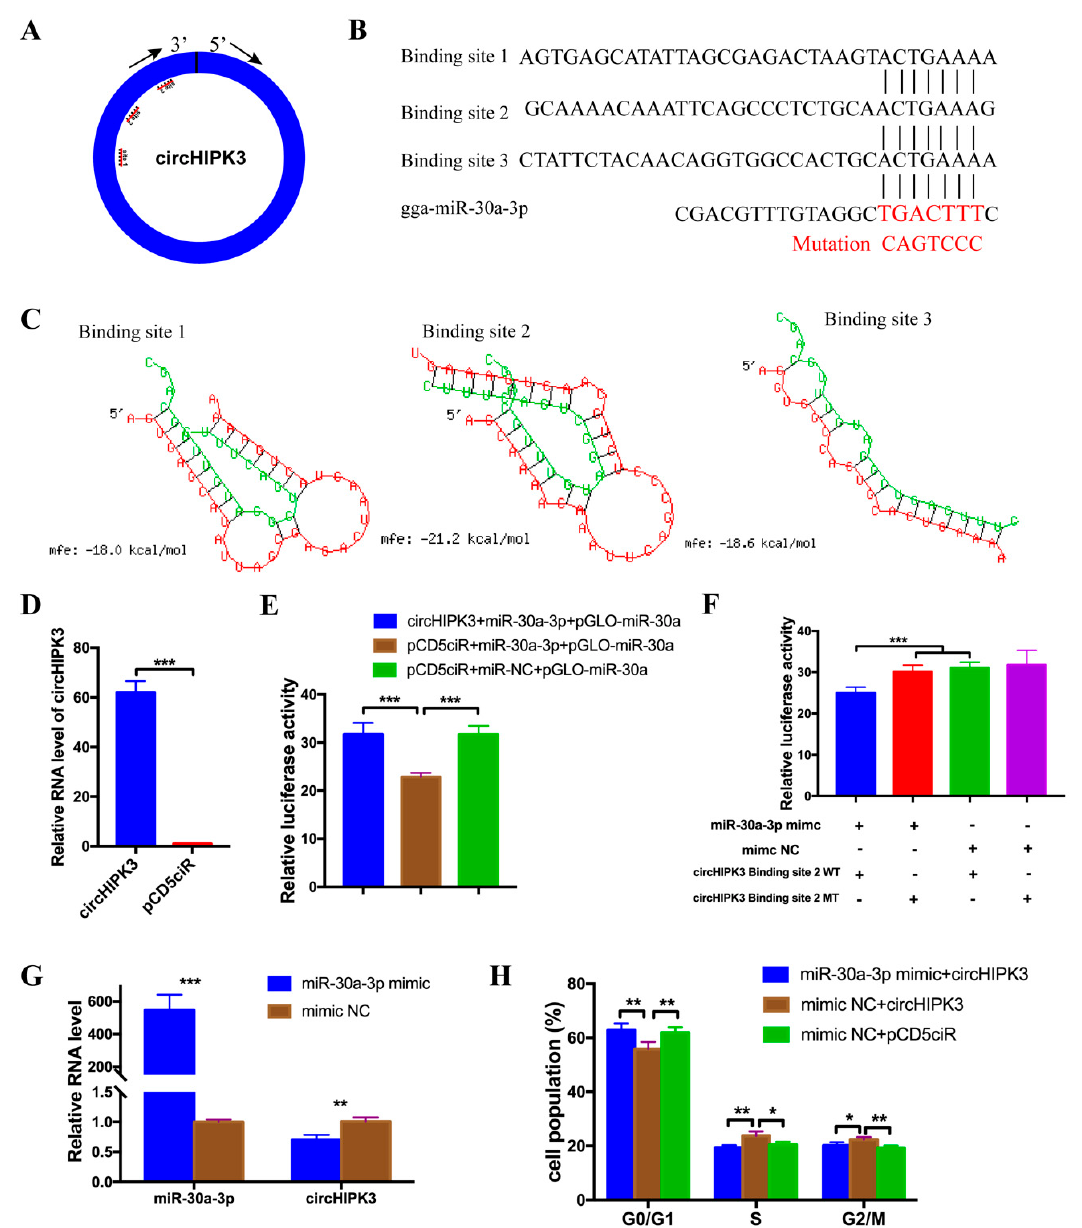
Figure 2. CircHIPK3 interacts with miR-30a-3p. ( A ) A schematic illustration showing the putative binding sites of miR-30a-3p on circHIPK3. ( B ) The potential binding site sequence of miR-30a-3p on circHIPK3. The seed sequences and mutant sequences were highlighted in red. ( C ) The potential interaction model between miR-30a-3p and circHIPK3 from RNAhybrid. ( D ) The expression efficiency of circHIPK3 over-expression vector in DF-1 cells. ( E ) Luminescence was measured after co-transfected with the luciferase reporter and miR-30a-3p mimic (or mimic NC) and circHIPK3 over-expression vector (or pCD5ciR). The relative levels of firefly luminescence normalized to Renilla luminescence are plotted. (n = 6). ( F ) Luminescence was measured after co-transfecting wild type or mutant linear sequence of circHIPK3 with miR-30a-3p mimic (or mimic NC) in DF-1 cells. (n = 6). ( G ) The RNA levels of miR-30a-3p and circHIPK3 from miR-30a-3p mimic transfected DF-1 cells. ( H ) The effect of co-transfected with miR-30a-3p mimic (or mimic NC) and circHIPK3 over-expression vector (or pCD5ciR) on cell-cycle progression of DF-1 cells. The plot of cell-cycle analysis in different cell-cycle phases was compared. In all panels, values represent mean ± SEM from three independent experiments. * p < 0.05; ** p < 0.01; *** p < 0.001.